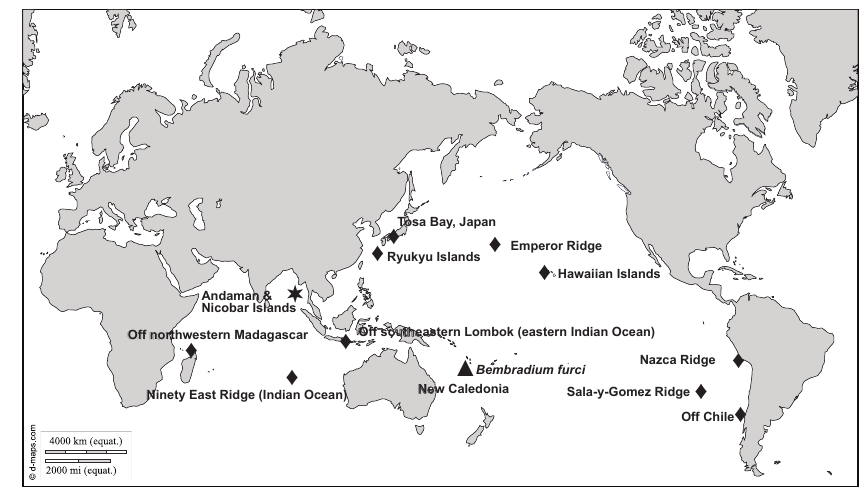
Fig. 2. Map showing the collection locations of Bembradium magnoculum (star symbol indicates the location of presently reported study; diamond symbol represents reports of Bembradium roseum; triangle marks a previous report of Bembradium furici ). Sources for reports of B. roseum include: Gilbert (1905), Jordan and Richardson (1908), Jordan and Jordan (1922), Fowler (1928), Tinker (1944), Böhlke (1953), Gosline & Brock (1960), Clarke (1972), Novikov et al. (1981), Kanayama in Okamura et al. (1982), Gloerfelt-Tarp and Kailola (1984), Humphreys et al. (1984), Ochiai in Masuda et al. (1984), Yatou in Okamura (1985), Borets (1986), Pequeno (1989), Rivaton et al. (1990), Parin (1991), Chave and Mundy (1994), Parin et al. (1997), Rivaton and Bourret (1999), Ho et al. (2009), Nakabo (2000), Shinohara et al. (2001), Nakabo (2002), Mundy (2005), Shinohara et al. (2005), Fricke et al. (2011), Timohin et al. (2017), Fricke et al.